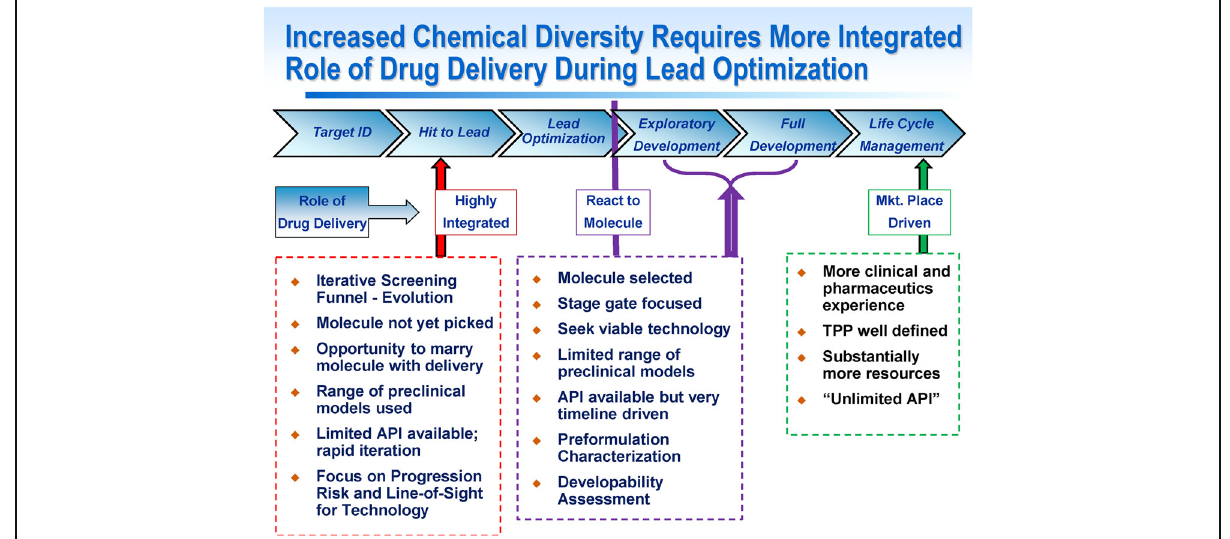
Fig. 3 Schematic of integrated role of drug delivery during lead optimization (Hageman, June LOL Conference, University of Wisconsin, June